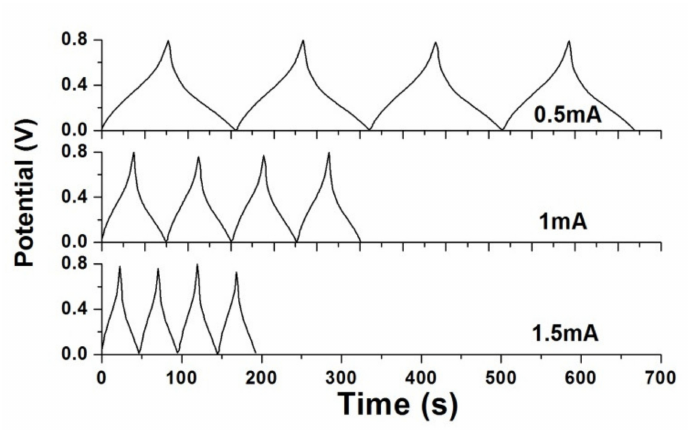
Figure 10. Galvanostaticcharging / discharging(GCD)curvesof100 ◦ C-annealedrGO / PANIsupercapacitor.